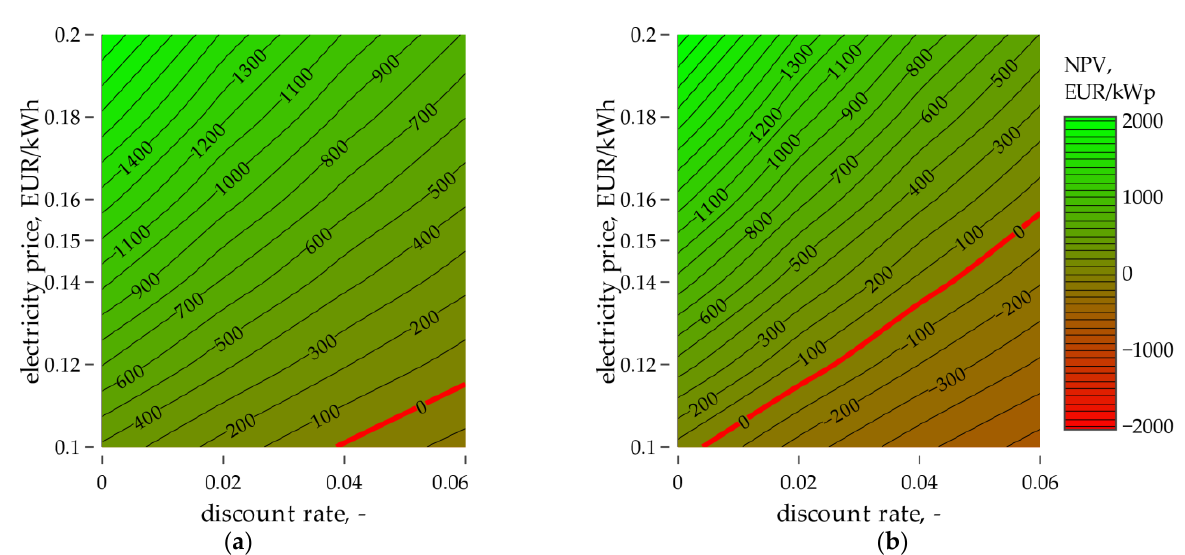
Figure 21. Net Present Value (NPV) as a function of electricity price and discount rate value: ( a ) for Leki; ( b ) for Bydgoszcz. ElP = 0.15 EUR/kWh is actual electricity price in Poland.